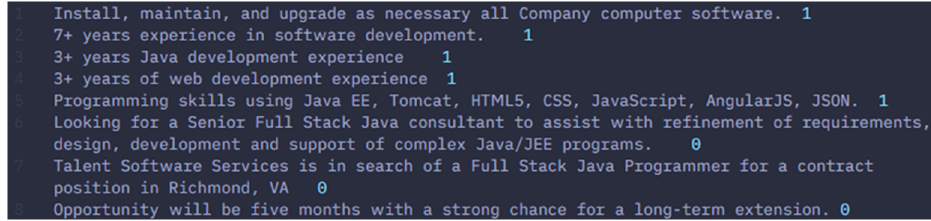
Figure 7. Part of the training set to verify if the sentence contains job